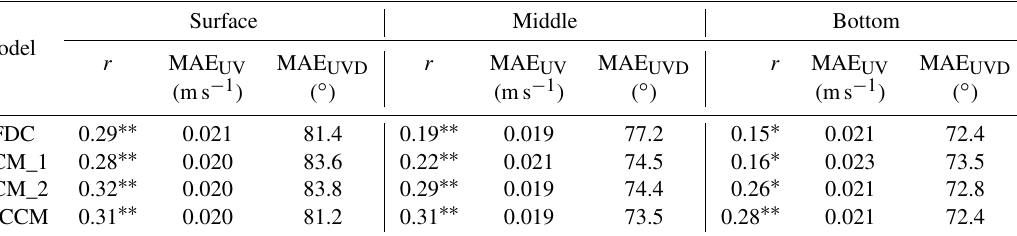
Table 5. Correlation coefficient (r) and mean absolute error between the simulated and measured current velocity (current speed, MAE UV ; current direction, MAE UVD ) during the 2018 winter observation for the numerical experiments. Note that * indicates p< 0 . 05 and that ** indicates p< 0 . 01.